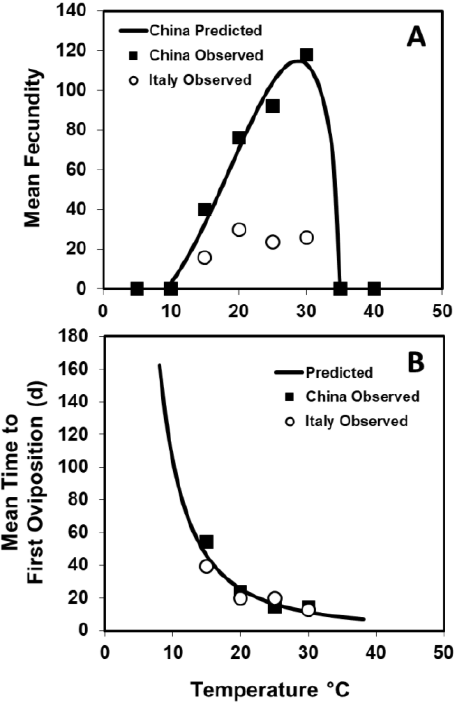
Table 3. Effects of temperature on Anoplophora chinensis egg hatch (mean ± SE (n)).